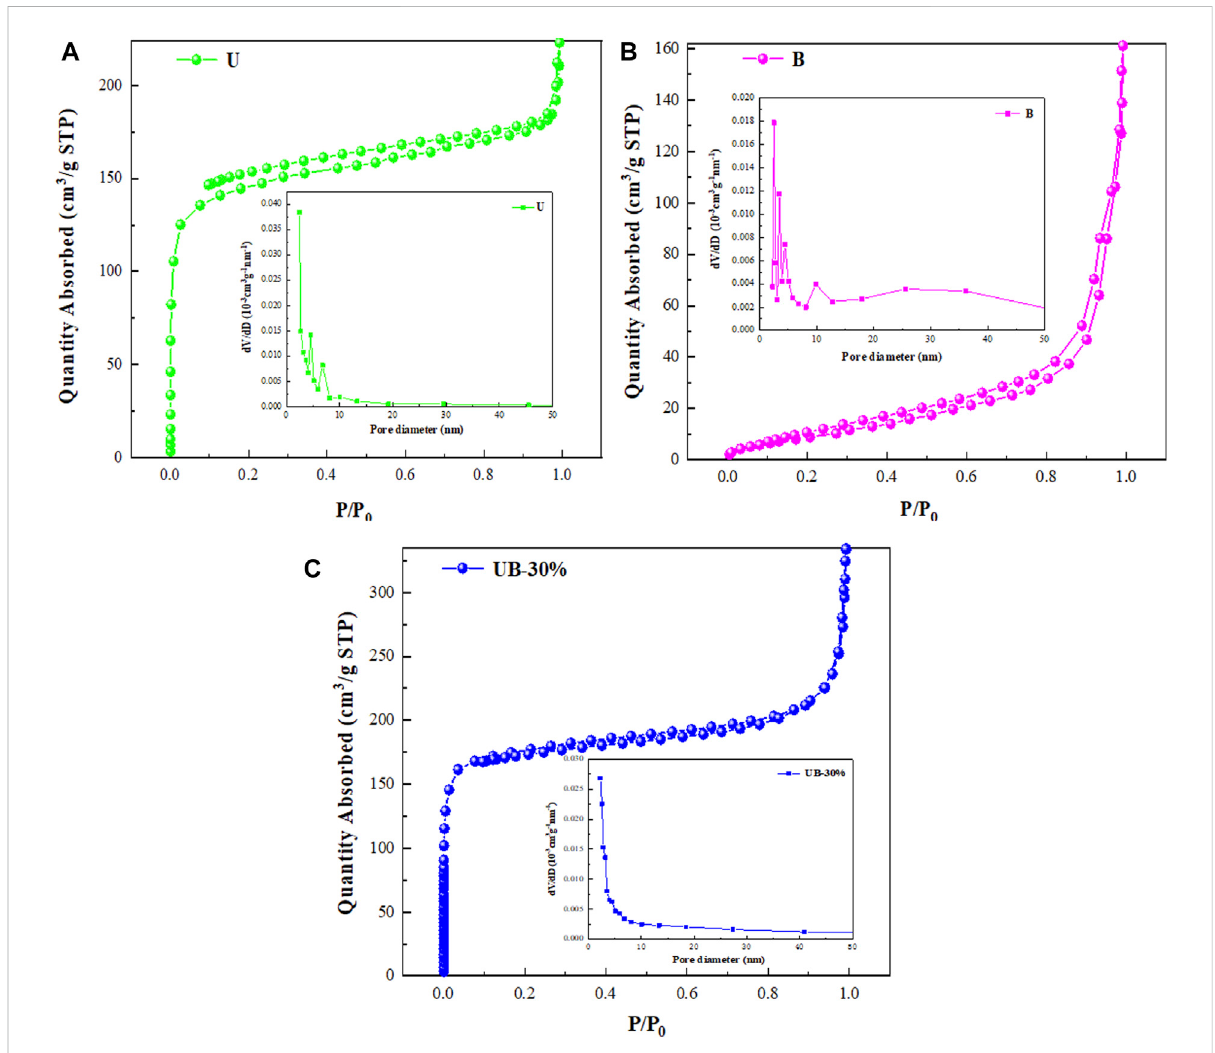
FIGURE 3 N 2 adsorption-desorption isotherm and aperture distribution of U (A) , B (B) and UB-30% composite (C) .